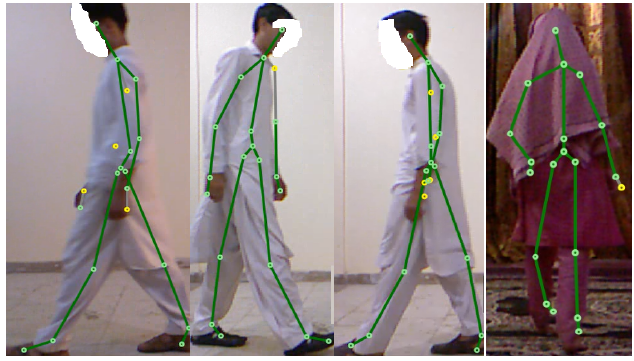
Figure 3. Walking of different subjects from different directions.